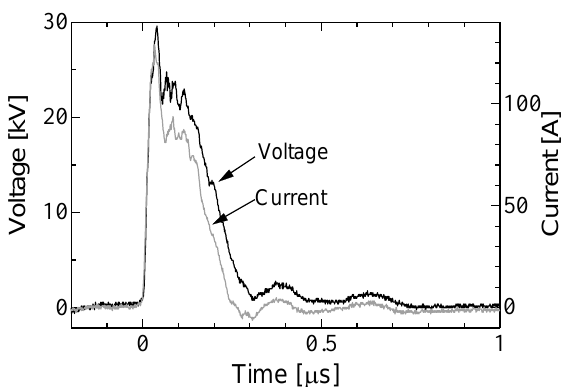
Figure 11. Waveforms of applied voltage and current to the Lyophyllum deeastes Sing. Sawdust block using. C-W circuit.